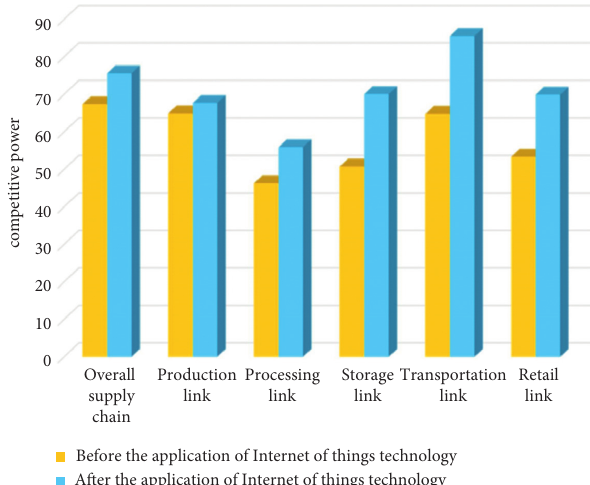
Figure 6: Comparison results of the competitiveness of each link of the rural economic supply chain and the overall supply chain before and after the use of the Internet of Things.